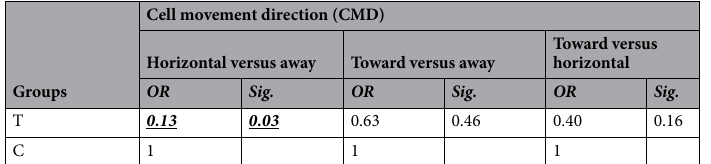
Table 1. The influence of two types of titanium sheet micromorphologies (T and C) on CMD (n = 25). Significant values are in [bolditalics and underline]. The statistical significance was set at P < 0.05.